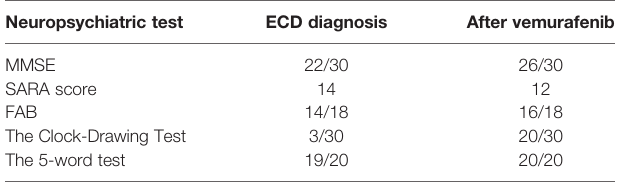
TABLE 1 | Evolution of the neuropsychiatric tests at diagnosis and after vemurafenib. Neuropsychiatric